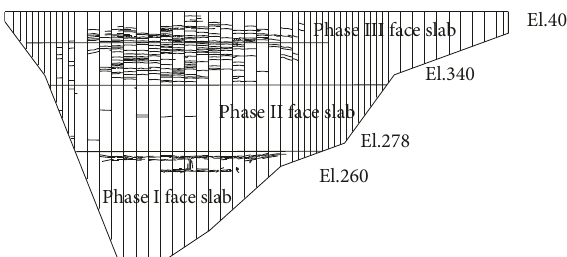
Figure 1: Sketch of the slab crack distribution at Shuibuya Power Station.